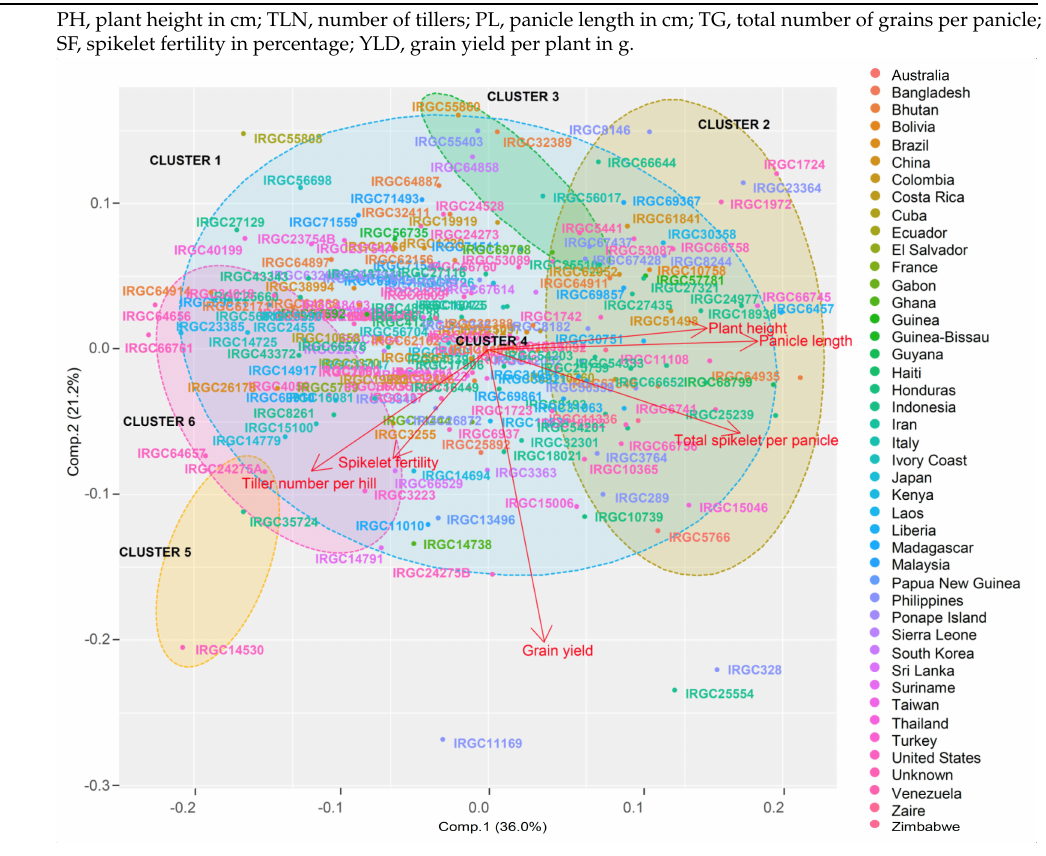
Figure 2. PCA based on agronomic data. Panicle length, grain number, plant height, and spikelet fertility accounted for the maximum variability along with the first principal component, while grain yield and tiller number accounted for the variation along the second principal component axis. The grouping of the genotypes showed at least five clusters with maximum concentration in one cluster. The geographical distribution across clusters showed no definite pattern, indicating that the tropical japonica genotypes had a common origin and were distributed across the globe through domestication